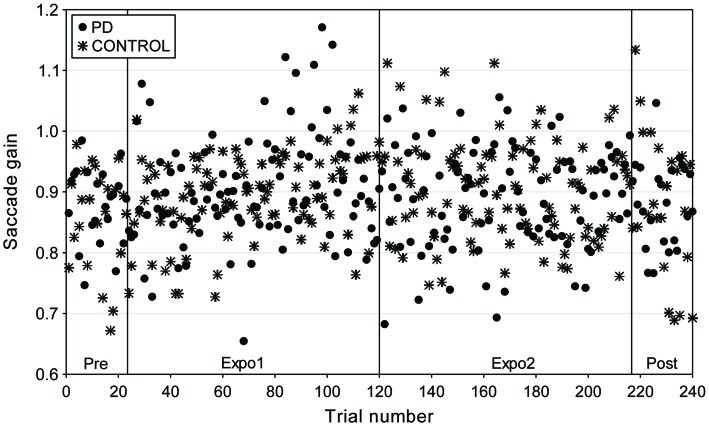
Time-course of gain changes for a representative subject (PJ) in the “PD” and “CONTROL” conditions of experiment II (adaptive saccade lengthening). Saccadic gain is plotted as a function of trial number for the different experimental phases: Pre (trials 1–24); exposure 1 (Expo1: trials 25–120); exposure 2 (Expo2: trials 121–216) and post (trials 217–240). Different symbols represent the gain of saccades in the “PD” (filled circles) and “CONTROL” (star) conditions.